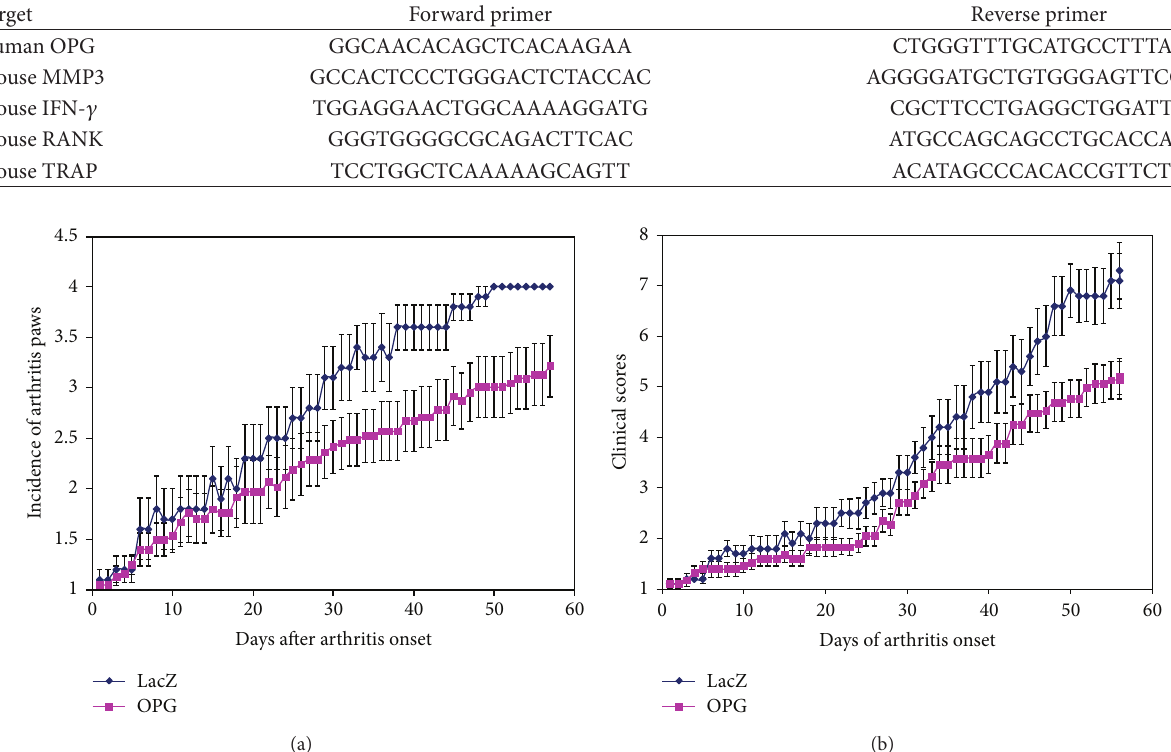
Figure2:SummaryofclinicalassessmentofCIAmicewithorwithoutOPGgenemodification.Panel(a)showsthemeannumbersofarthritic paws of each mouse during the disease progression, while panel (b) illustrates the arthritis scores of arthritic paws from the day of disease